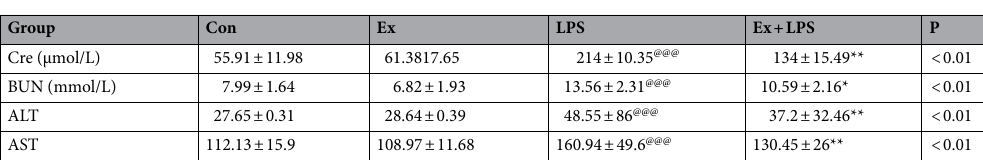
Table 4. Effects of AE on Gre, BUN, ALT and AST levels in serum. The markers of liver damage (ALT and AST) and markers of kidney damage (Cre and BUN) in serum were detected. @@@ P < 0.001, Con versus LPS groups. * P < 0.05, LPS versus Ex + LPS groups. ** P < 0.01, LPS verus Ex + LPS